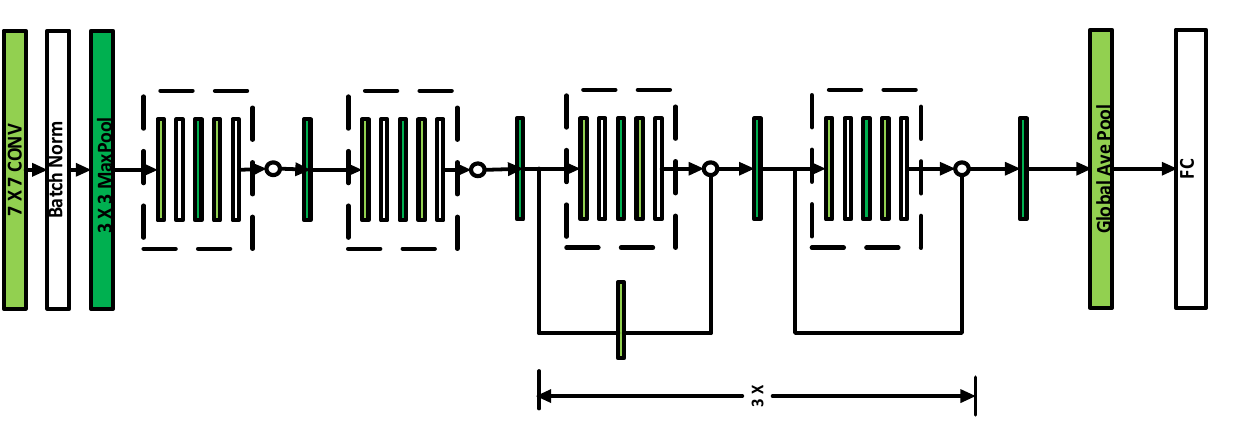
Figure 2. The ResNet-18 Architecture.